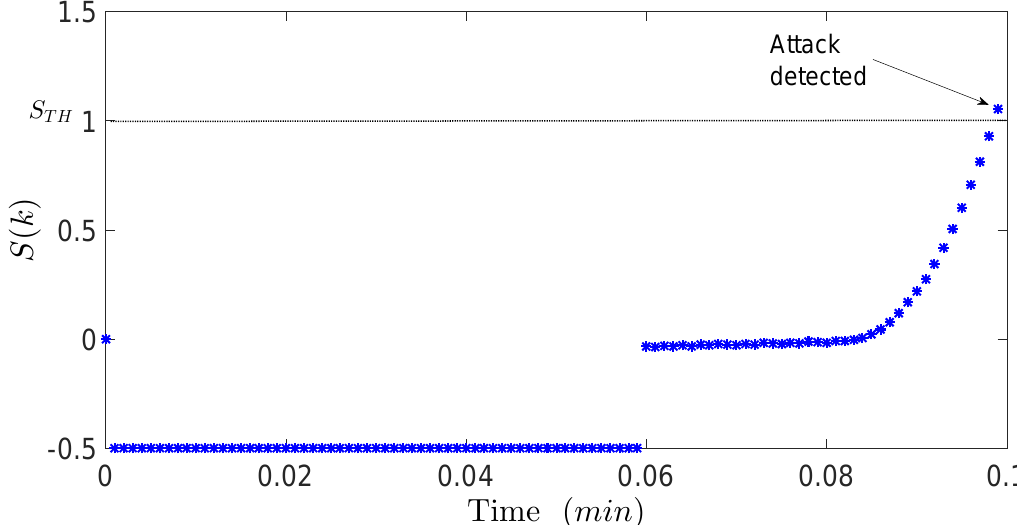
Figure 8. The variation of S ( k ) for the initial condition ( − 0.25, 3) under the LMPC of Equation (14) and the model-based detection